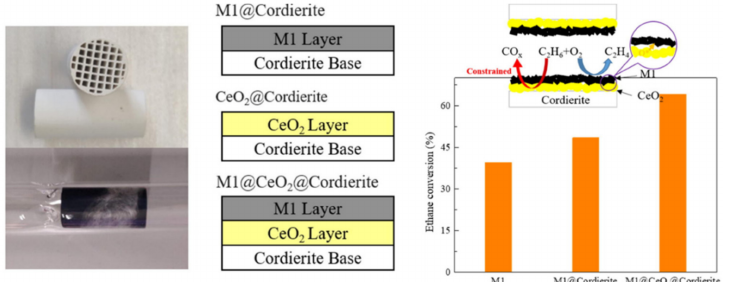
Figure 21. Scheme of M1@CeO 2 @Cordierite structured catalyst and catalytic performance for the ODHE process. Adapted from ref. [27], Copyright (2022), with permission from